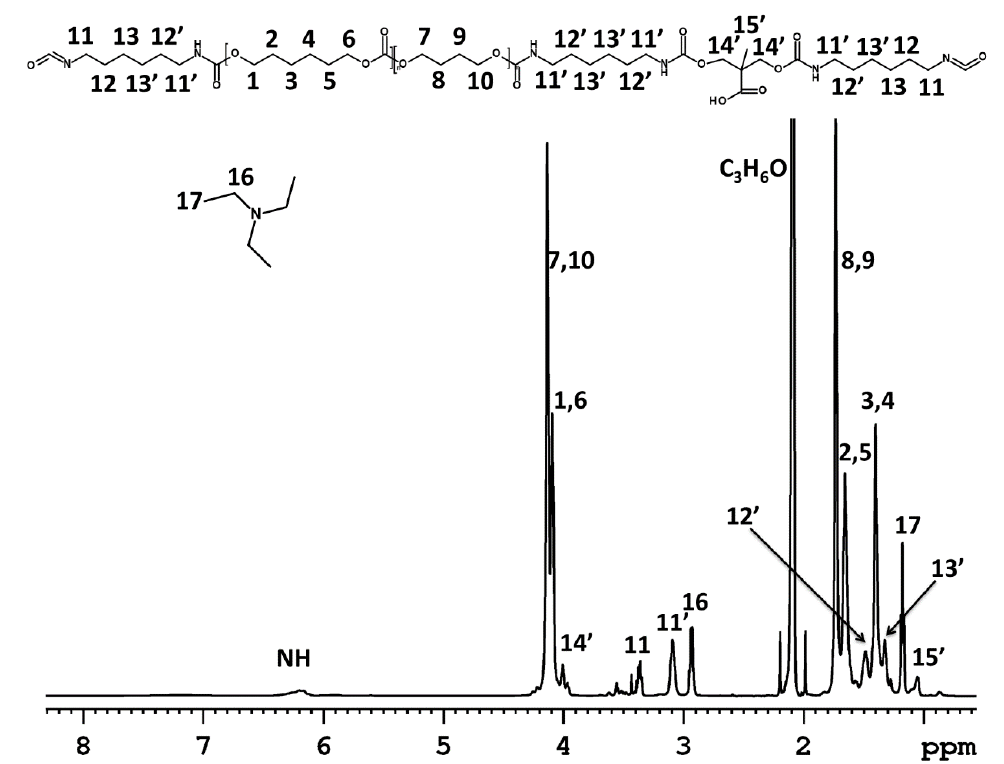
Figure 3. Proton nuclear magnetic resonance ( 1 H NMR) spectrum of the reaction mixture measured at 22 °C after polyaddition and neutralization reactions using deuterated dimethylformamide (DMF) as the external solvent (in a capillary).